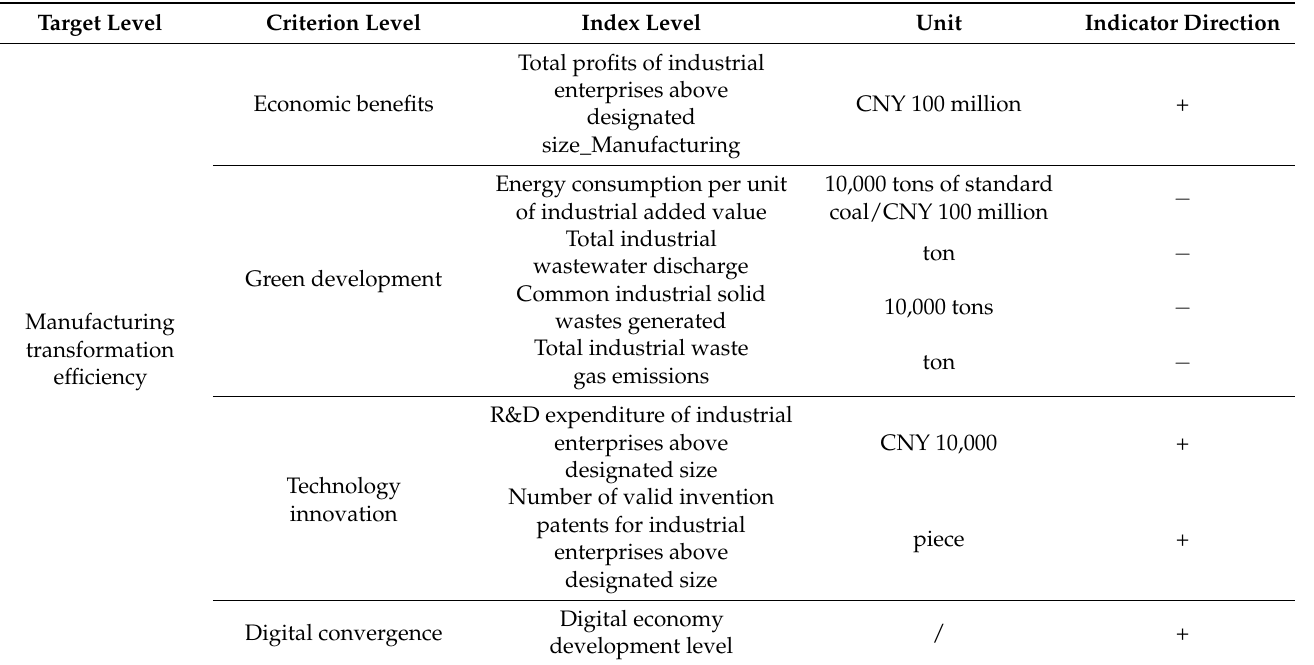
Table 3. Manufacturing transformation efficiency evaluation